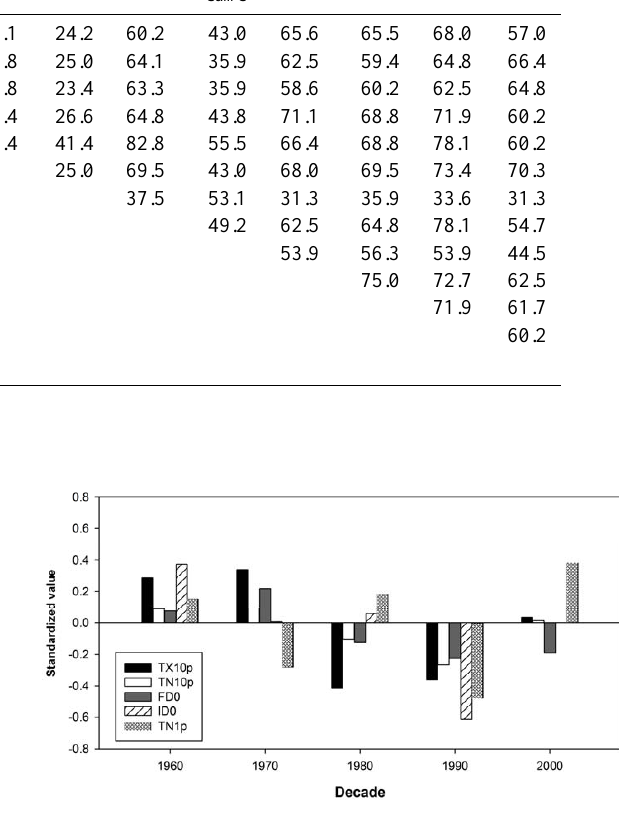
Figure 10. Decadal variation of a set of the cold temperature frequency indices, Fig. 10. Decadal variation of a set of the cold temperature frequency averaged for the whole study area. The annual number of events was standardized by indices averaged for the whole study area. The annual number of their mean and standard deviation to account for different scale units of the indices. events was standardized by their mean and standard deviation to account for different scale units of the